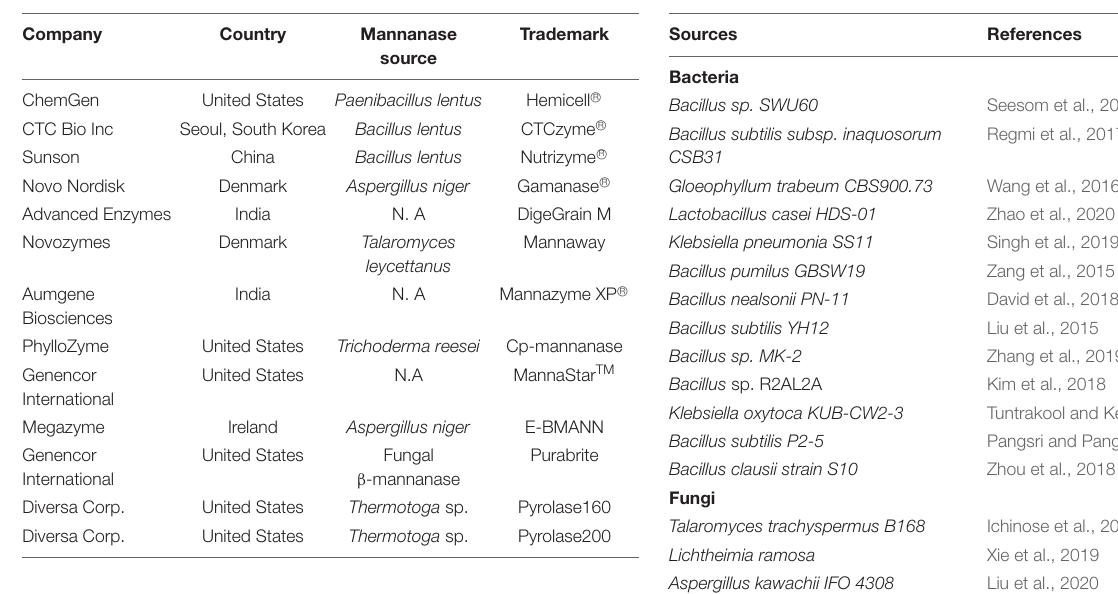
TABLE 1 | Commercial production information of β